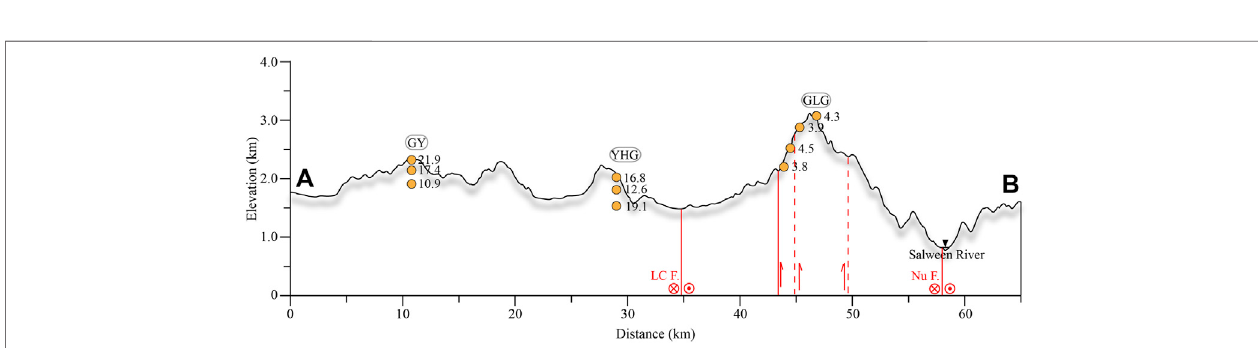
FIGURE 3 | Topographic cross section of Tengchong area (Figure 1 : A,B) . The numbers in the fi gure represent the ages of AHe. GY, Guyong transect; YHG, Yinghua Valley transect; GLG, Gaoligong transect; Nu F, Nujiang fault; LC F, Longchuangjiang fault.